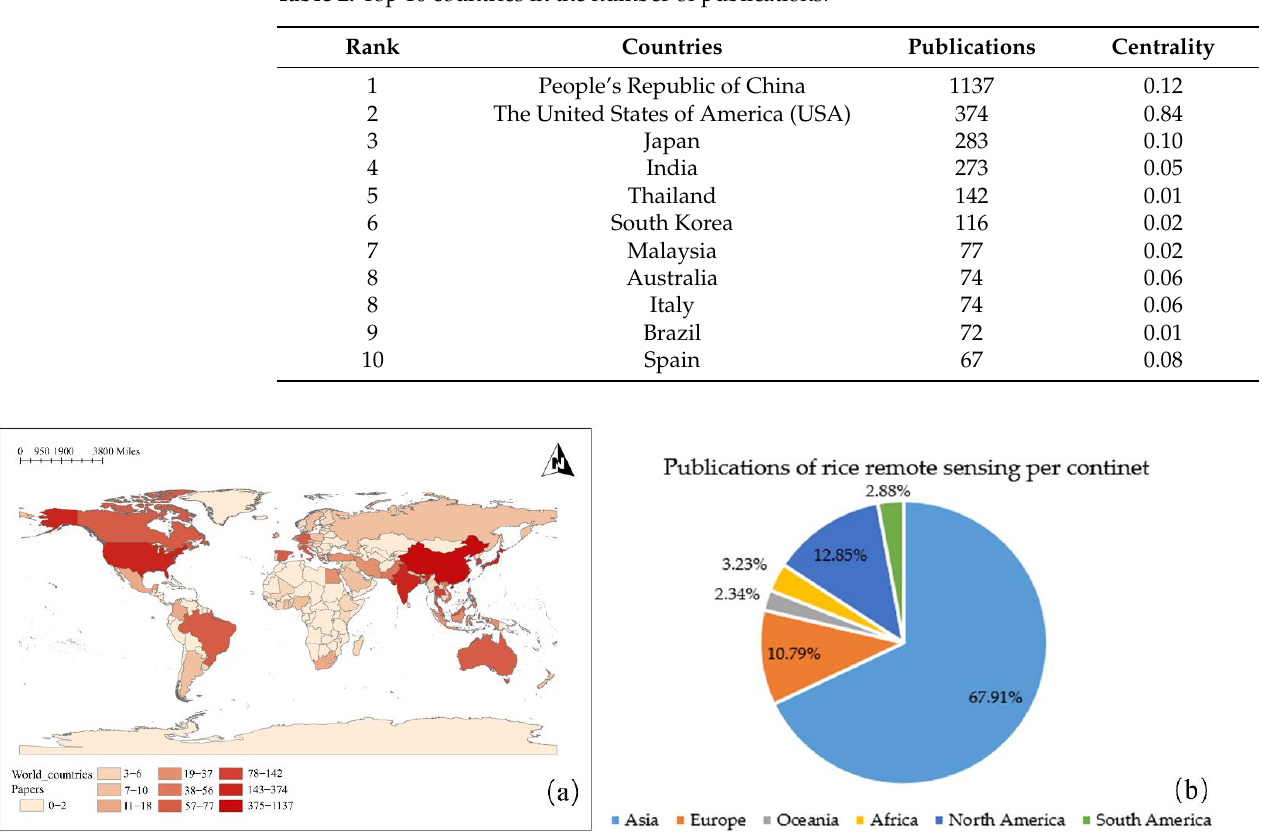
7 of 22 Table 2. Top 10 countries in the number of publications. Rank